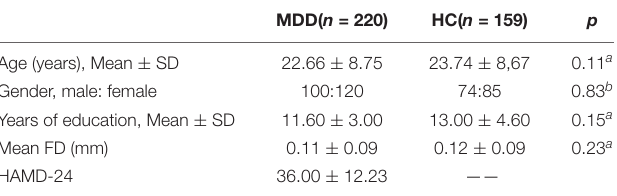
TABLE 1 | Characteristics of patients with MDD and healthy controls.